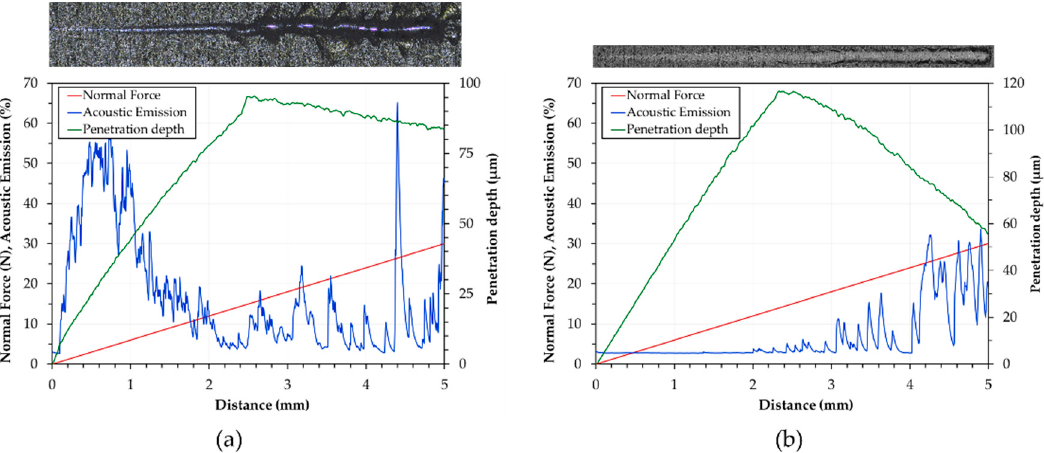
Figure 5. Optical micrographs of scratches on pin surfaces with anodic aluminum oxides of ( a ) 25 and ( b ) 50 µ m, and the corresponding graphs of normal force, acoustic emission, and penetration depth vs. scratch distance.